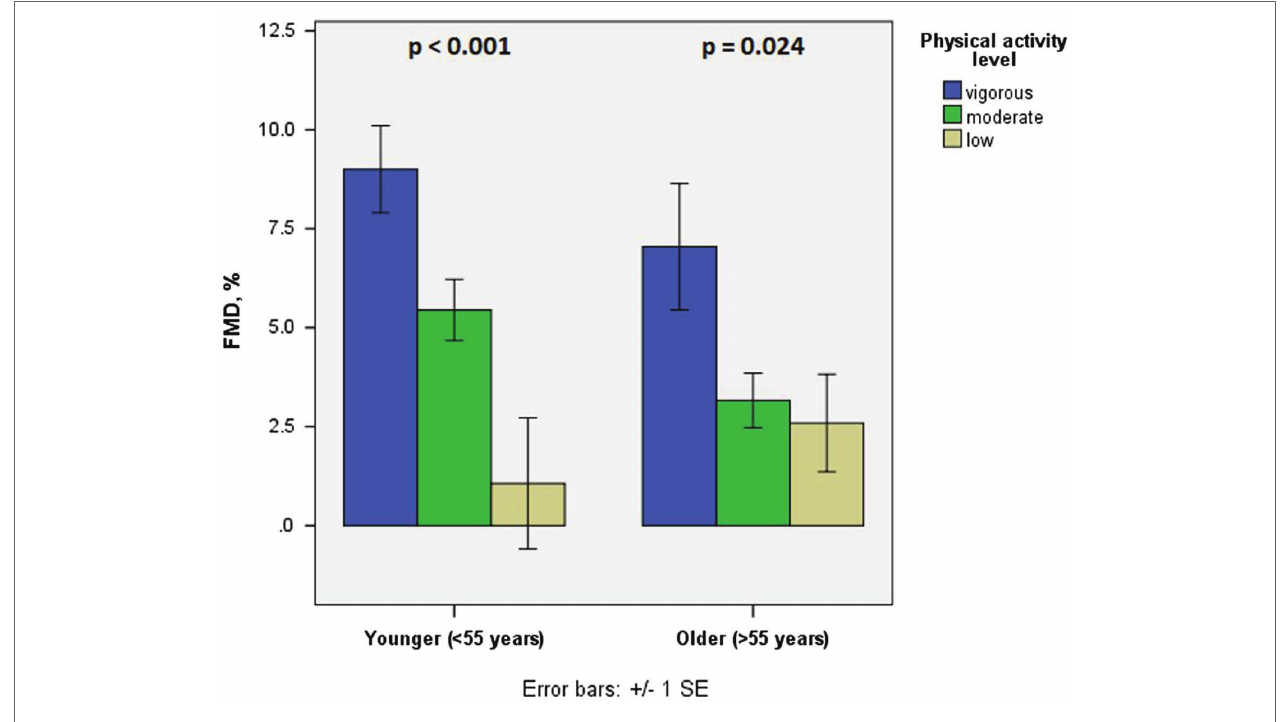
FIGURE 1 | Flow-mediated dilation in different age groups in terms of physical activity